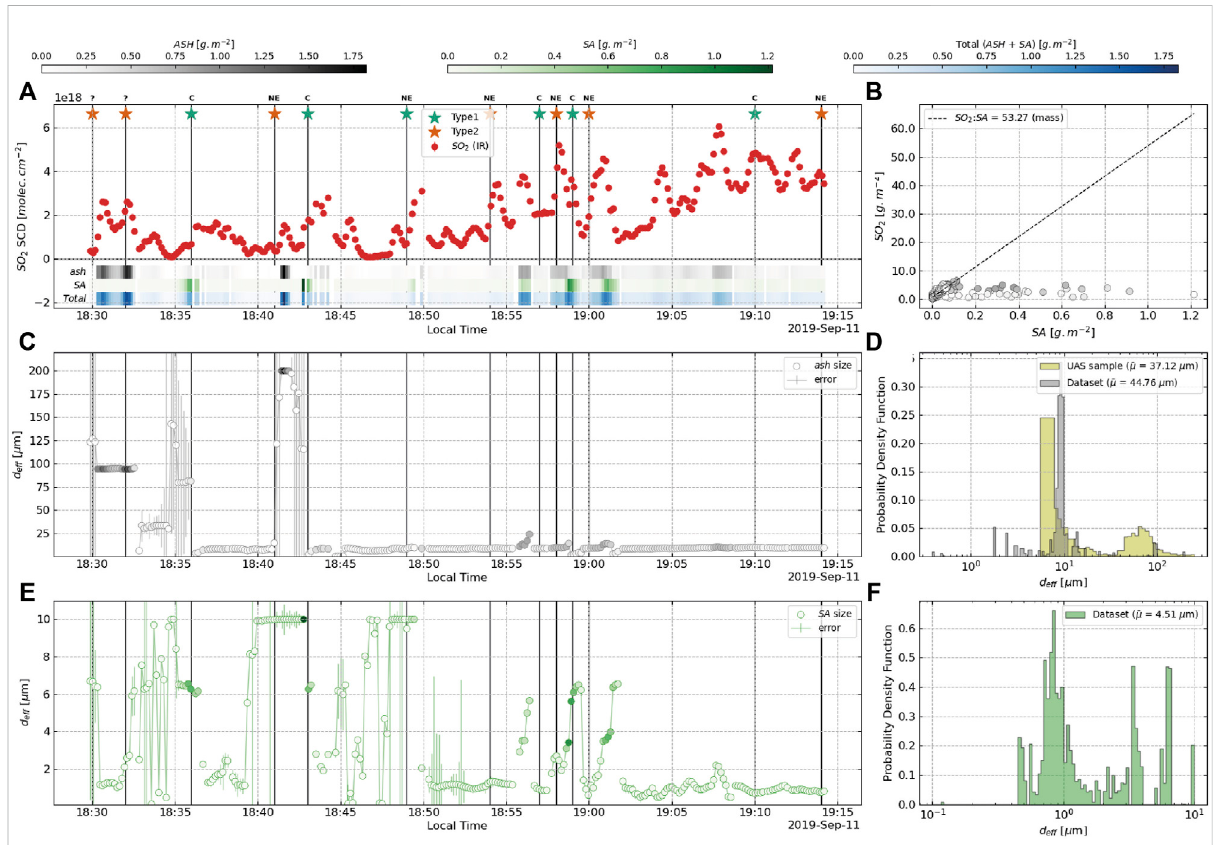
FIGURE 9 Timeseriesofretrievedquantitiesforadatasetcollecteddirectlyabovetheventson11September2019 (A) SO 2 SCDs[red].Errorbarsrepresent the modelling error only (i.e., the covariance estimated during the linear regression). Stars represent individual events visually documented in the crater area (type 1 or 2), labelled according to the vent from which they originated (NE: northeast; C central). The mass SCDs for ash [grey], sulphate aerosols[SA,green],andthetotalparticulates[blue]foreachindividualmeasurementarealsoshownincolourbarslocatedatthebottomofthe plot(colourscalesatthetop) (B) ScatterplotbetweenSO 2 andSASCDs,andthelinear fi tforthisdata(SO 2 /SAratio=53.27).Individualdatapointsare coloured according to the ash SCD (C) Retrieved effective diameter for ash particles (D) Histogram of the retrieved ash sizes over the entire dataset [light grey] weighted according to the ash SCD to minimise the importance of measurements with very low amounts of ash. For comparison the particle size distribution measured in the ash sample collected with the RPAS is also shown [yellow] (E) Retrieved effective diameters for the SA (F) Histogramoftheretrievedsizesovertheentiredataset[lightgreen]weightedaccordingtotheSASCDtominimisetheimportanceofmeasurements with very low amounts of SA. Note that size distributions for both ash and SA are